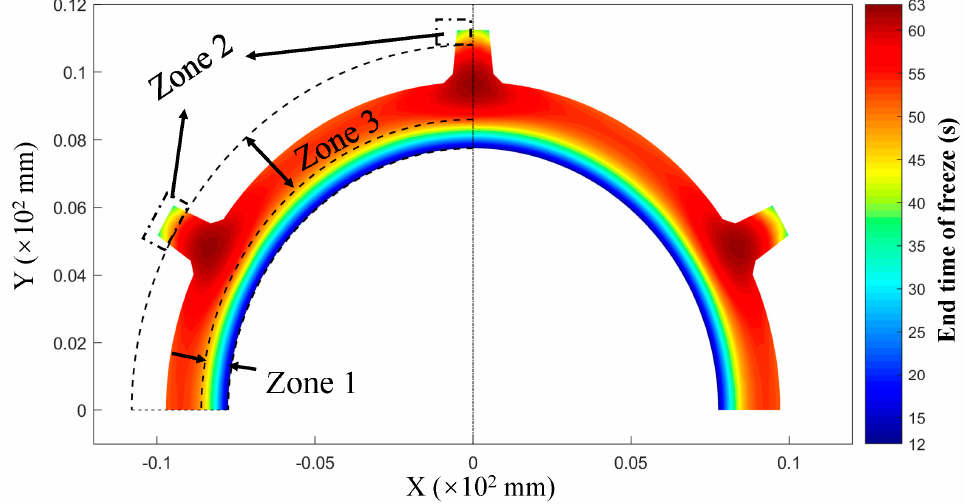
Figure 15. The end-of-freeze contour on the horizontal section.